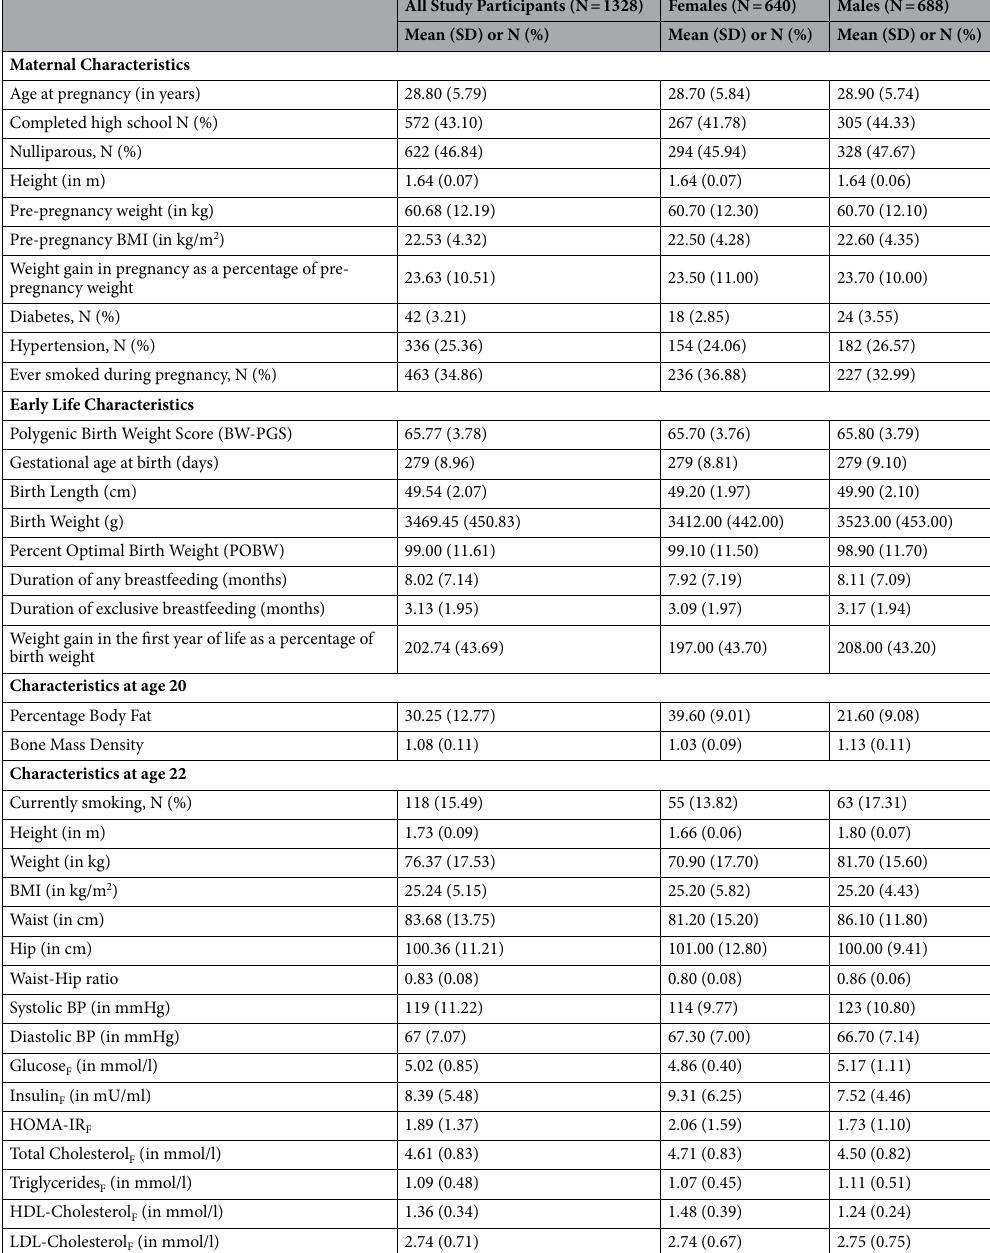
Table 1. Demographic table for study participants. F denotes